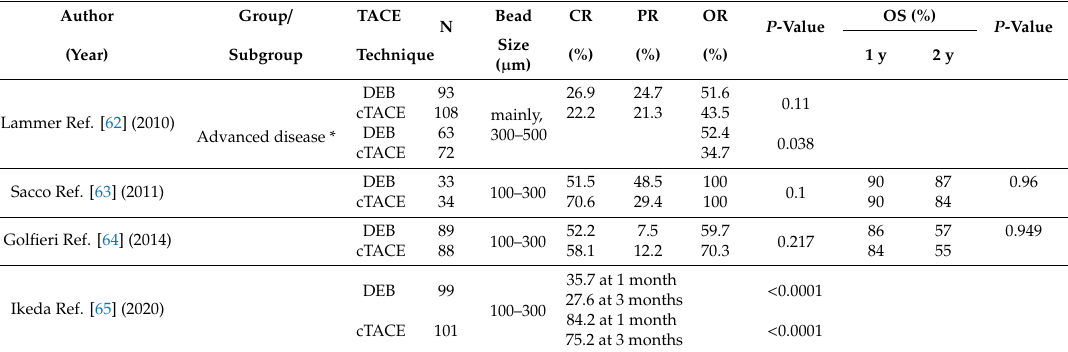
Table 1. Comparison of therapeutic e ff ects between DEB-TACE and